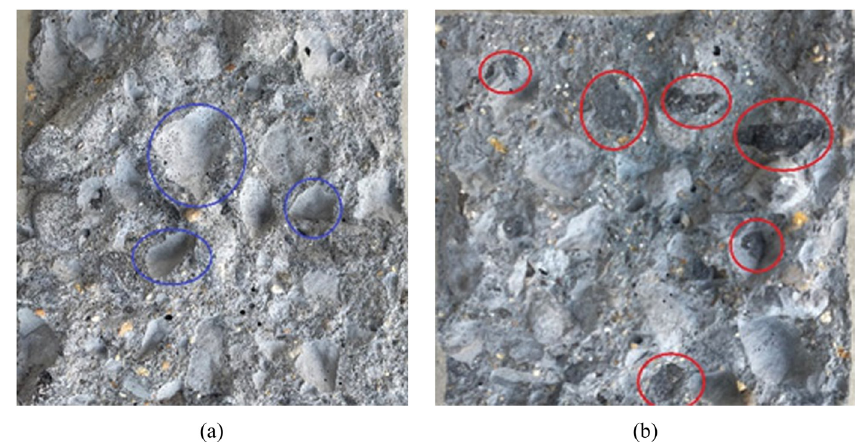
Figure 6: Cross sections: ( a ) NP and ( b ) CZ2 -